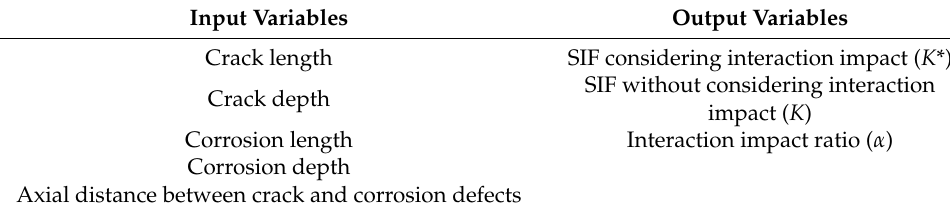
Table 1. Input and output variables of the proposed XGBoost